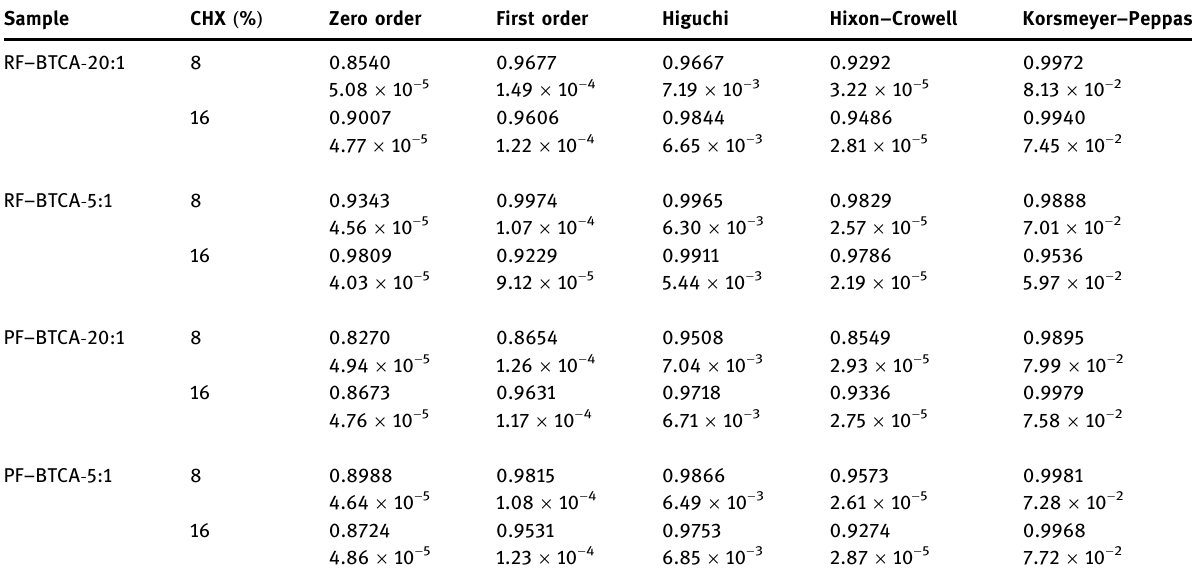
Table 4: R 2 and rate constant k for chlorhexidine release from cross - linked CP fi bers Sample CHX ( %